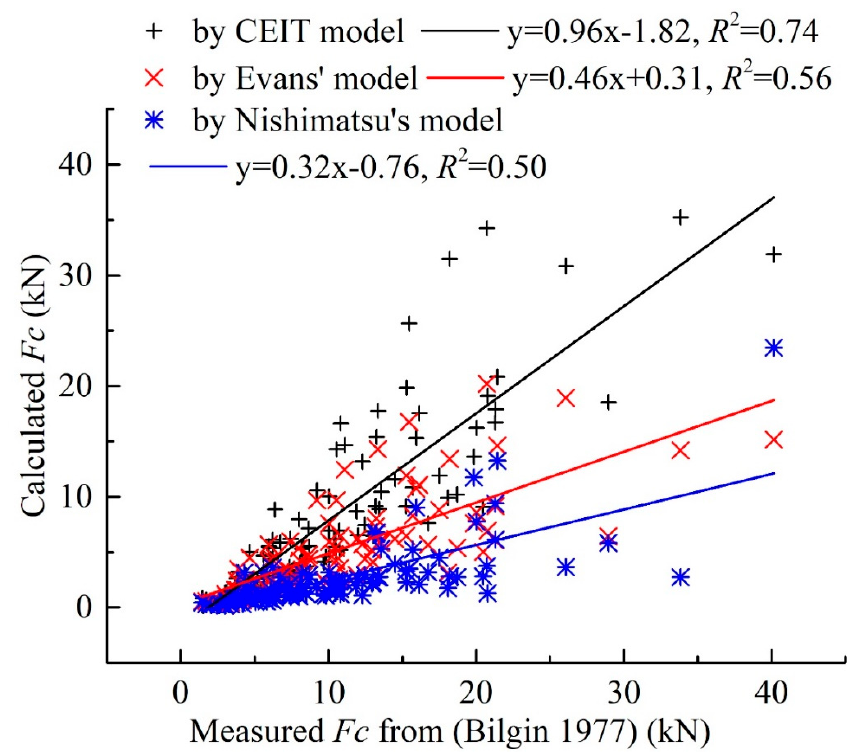
Figure 14. Comparison of the performance of different models in estimating the peak cutting forces in cutting greywacke.